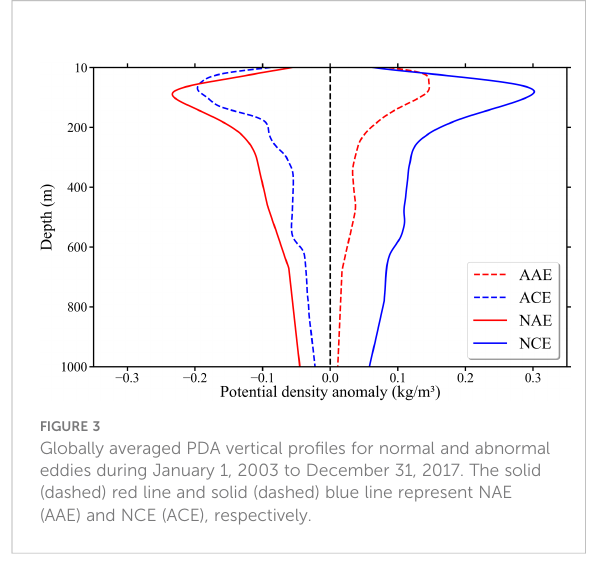
FIGURE 3 Globally averaged PDA vertical pro fi les for normal and abnormal eddies during January 1, 2003 to December 31, 2017. The solid (dashed) red line and solid (dashed) blue line represent NAE (AAE) and NCE (ACE),